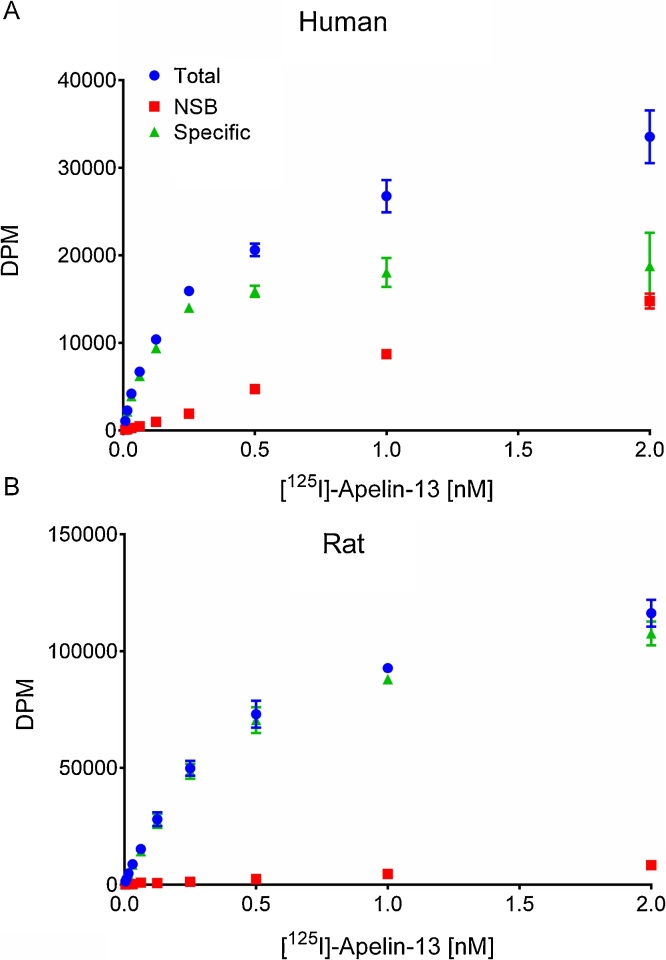
Characterisation of binding of [125I]apelin-13 to rat and human cardiac apelin receptors. [125I]-apelin-13 saturation binding in human (A) and rat (B) homogenates (n = 3 Replicates per concentration, data are mean ± SEM). NSB is non-specific binding defined in the presence of 2 μM [Pyr1]apelin-13.